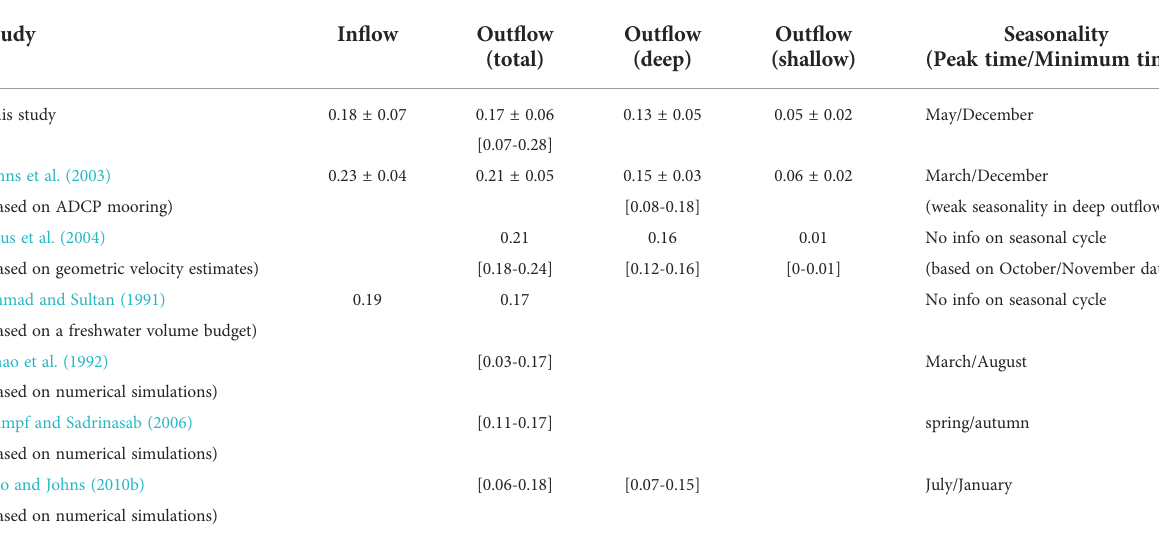
TABLE 1 Gulf out fl ow